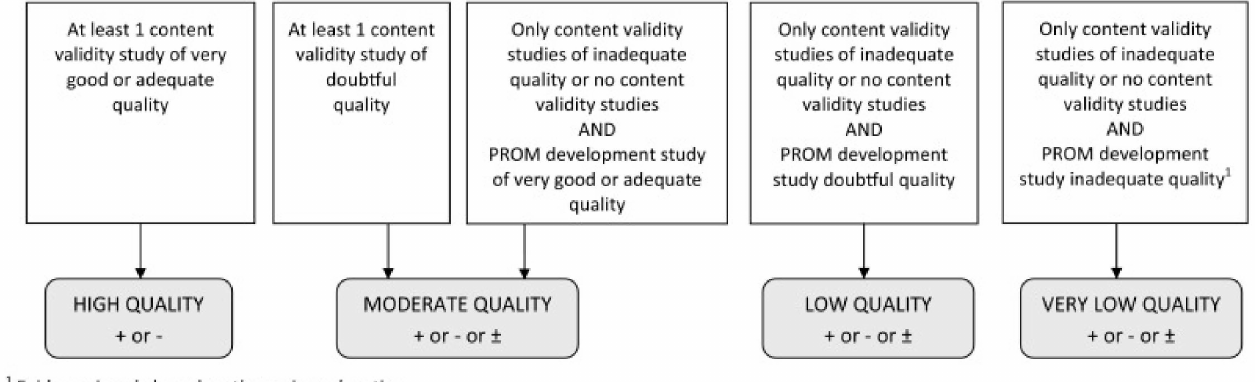
Figure 1. Modified GRADE approach for grading the quality of evidence. From Terwee et al. (2018)